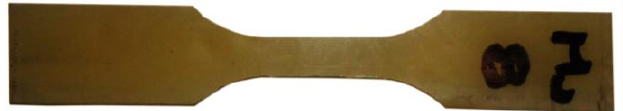
Commented [P1]: I changed figure 3.